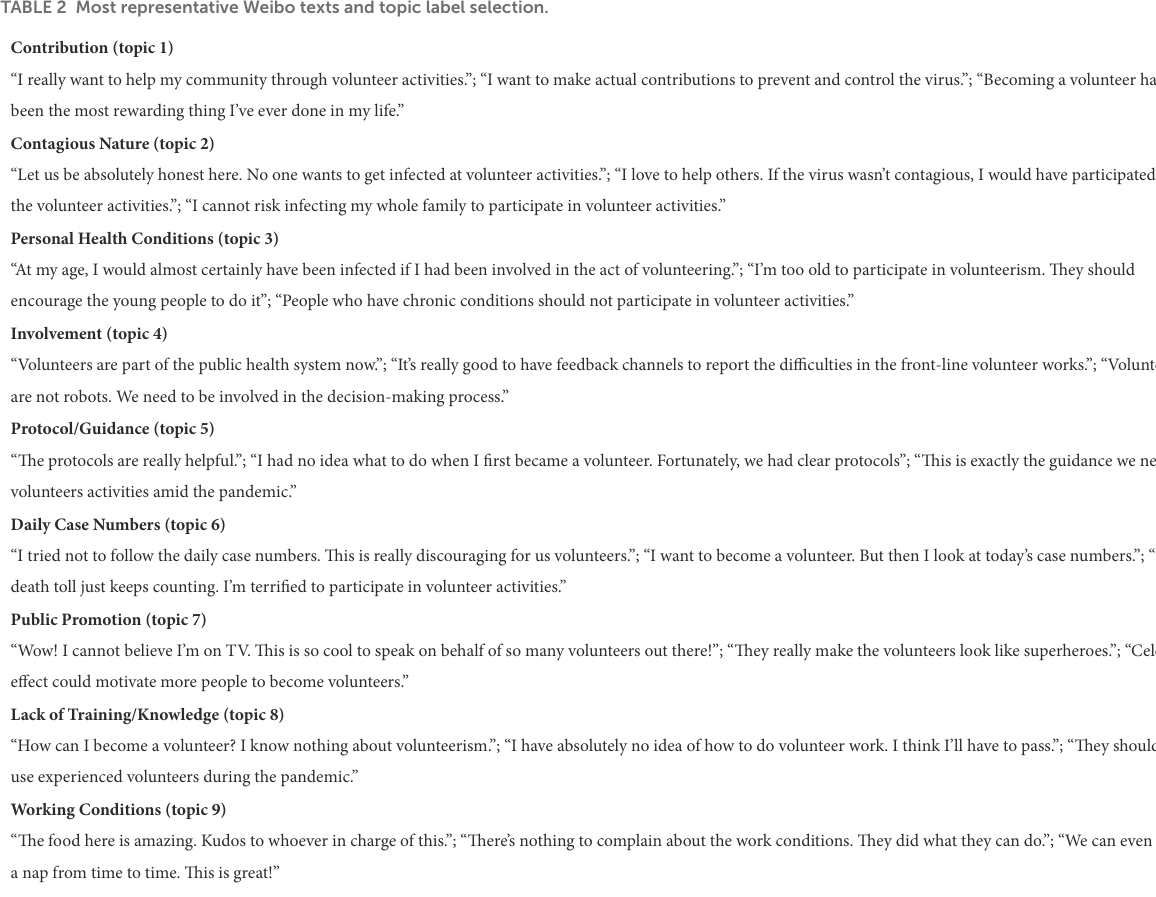
TABLE 2 Most representative Weibo texts and topic label